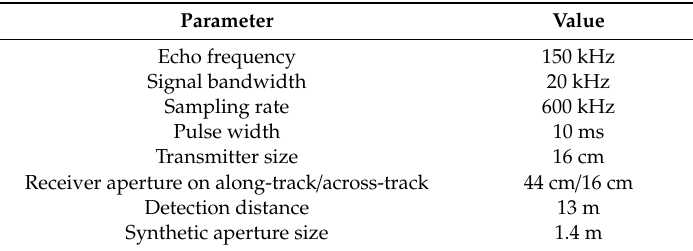
Table 4. Main parameters for MBSAS experiment